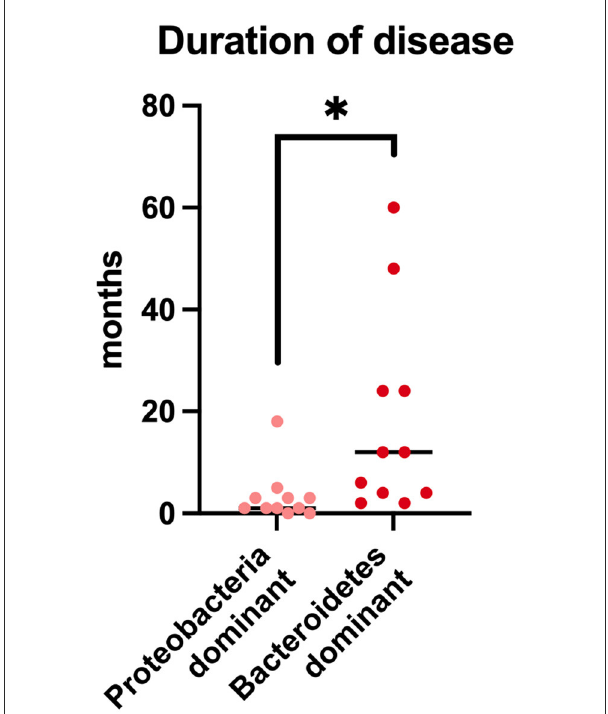
FIGURE5 Duration of disease prior to presentation in cats with chronic bronchial disease and predominantly Protebacteria in BALF-samples in comparison to cats with predominantly Bacteriodetes in BALF-samples. * p <